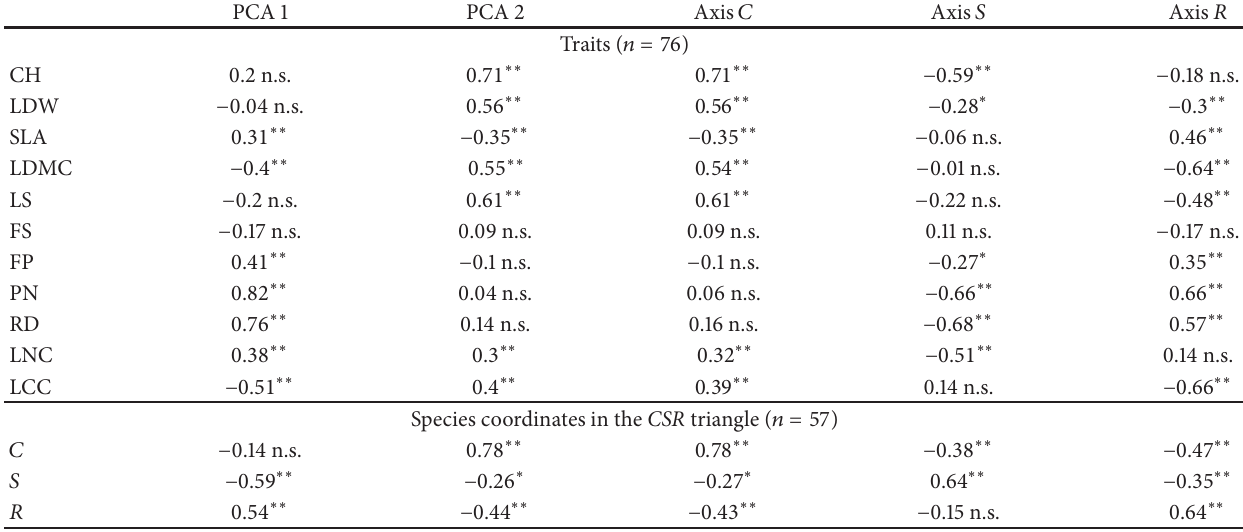
Table 3: Correlation between species traits, PCA axes score, and species coordinates in “Grime’s triangle.”